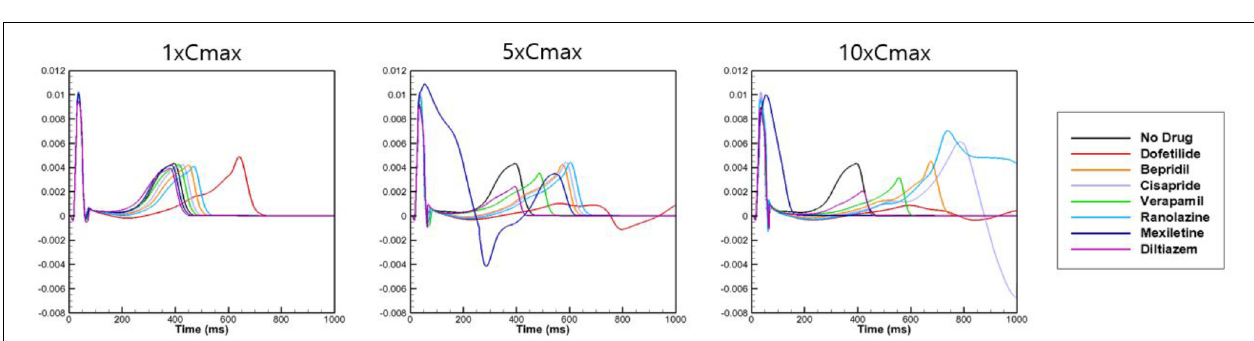
FIGURE 4 | Effects on body-surface ECG parameters. Body-surface ECG data (lead I) are shown for 7 drugs at Cmax values of 1 × , 5 × , and 10 × compared with drug-free conditions. The QT interval was longest for